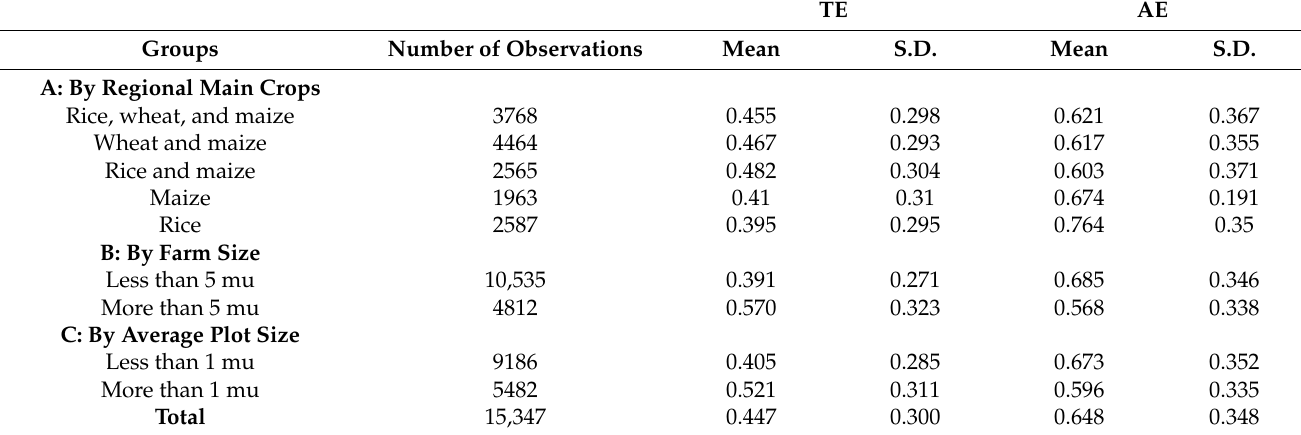
Table 3. Summary statistics of rural household